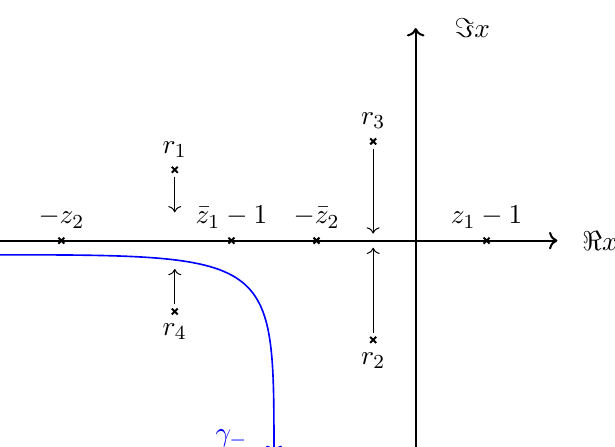
Figure 4 . In the soft limit p 10 → 0 , the roots of y 2 ( x ) pairwise pinch the integration contours for w + , w + − and w + , which run along the real axis. By subtracting w − ∞ and w + ∞ , respectively, ¯ z 2 ¯ z 1 − 1 z 1 − 1 we obtain integration contours that can be deformed such they are not pinched, thus resulting in finite integrals in the soft